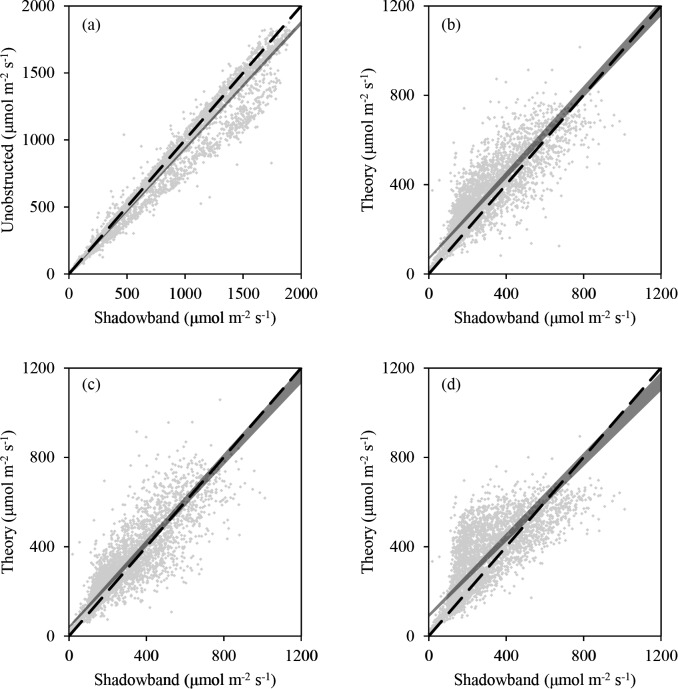
Scatter plots comparing PAR values measured by shadowband system with other accepted methods of quantifying PAR.Dashed line represents ideal one-to-one relationship and grey wedge represents the 95% confidence interval computed using Deming regressions. a) PART vs. unobstructed quantum sensor b) PARD vs. Spitters c) PARD vs. Erbs d) PARDvs. Jacovides